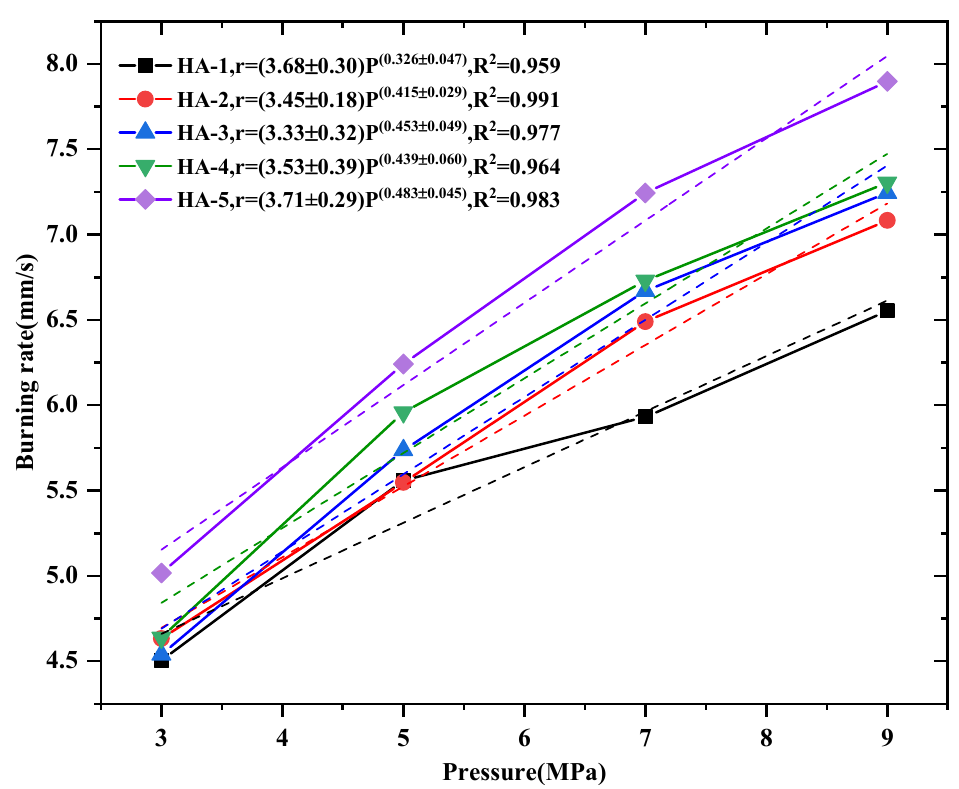
Figure 2. Linear burning rate and power-law pressure dependence in 3 MPa–9 MPa for solid pro- pellants.